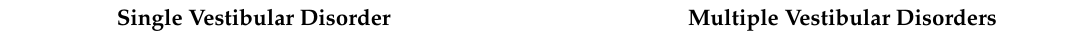
Table 1. Distribution of the episodic vestibular disorders (single or multiple) and Persistent